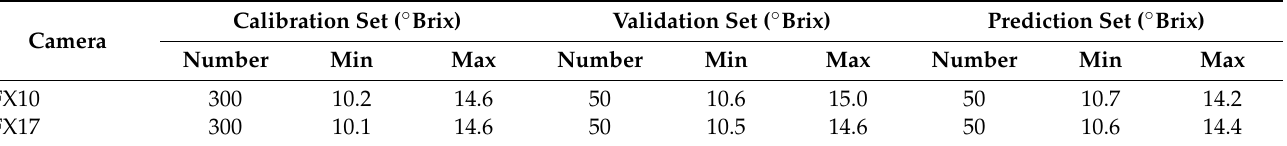
Table 1. Statistical analysis of reference values of samples in the calibration, validation, and prediction sets. Calibration Set ( ◦ Brix) Validation Set ( ◦ Brix) Prediction Set ( ◦ Camera